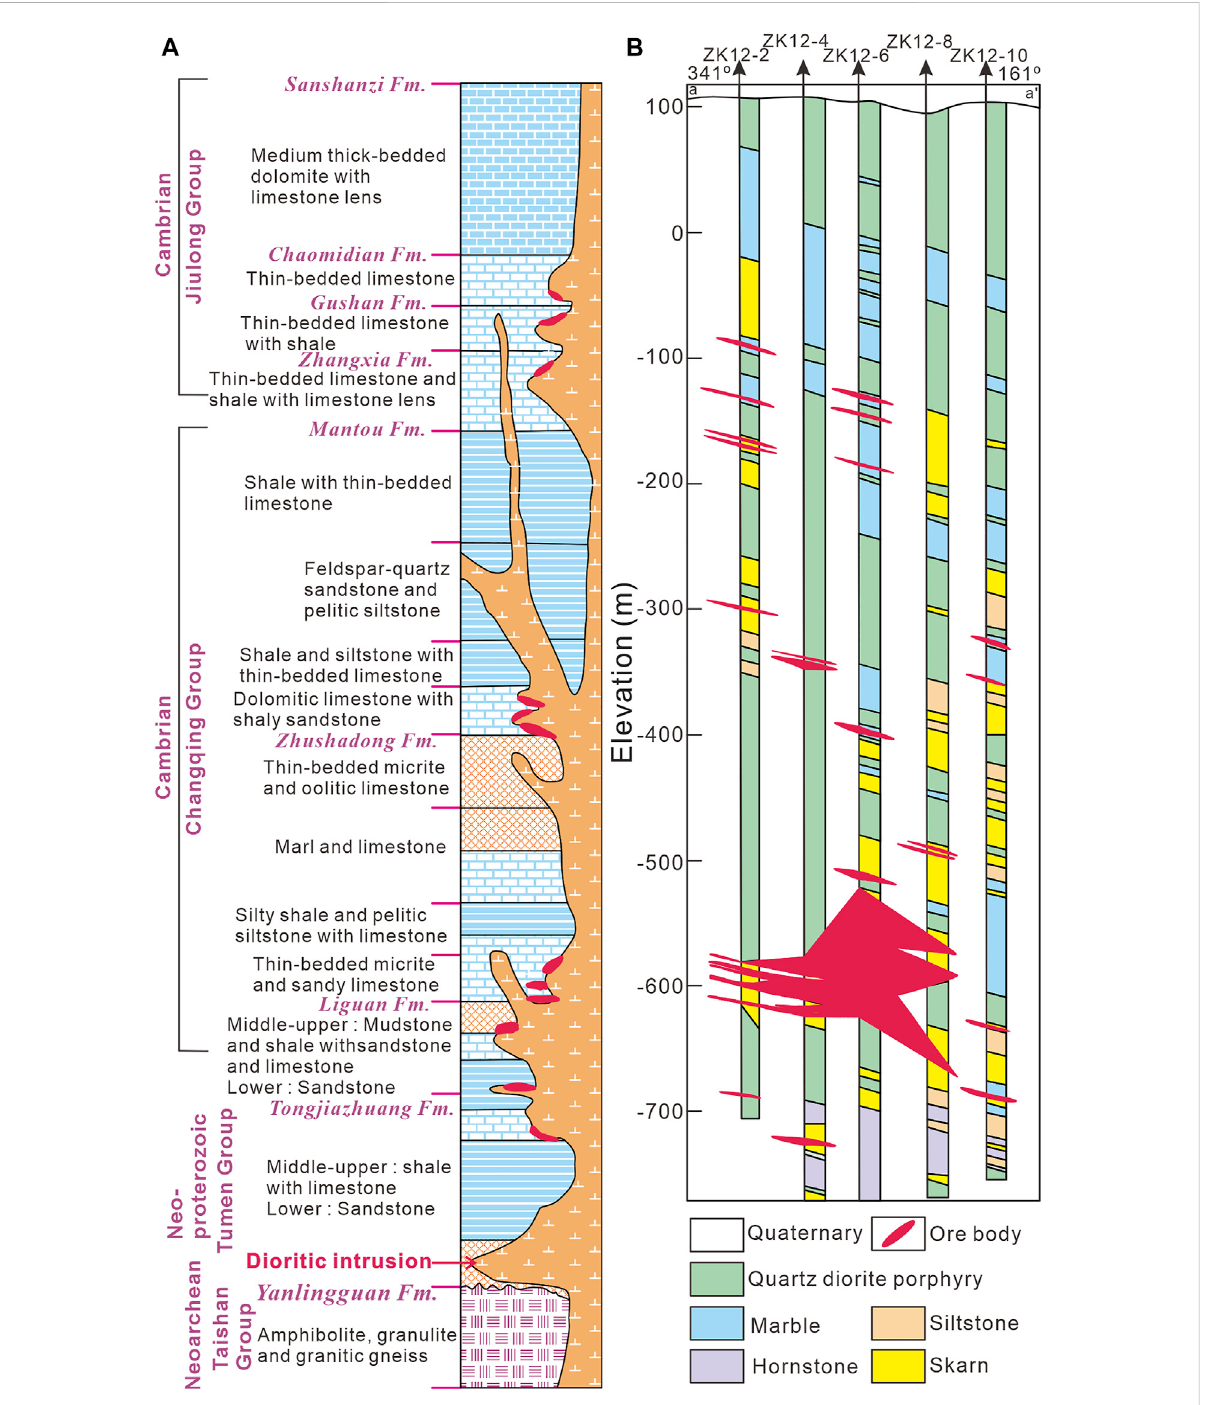
FIGURE 4 Sketchmapshowing thestratigraphyandtheoccurrenceoforebodiesintheYi ’ nanAu – Cuskarn deposit (A) ,modi fi edafterDong etal.(2008); Geological cross-section along exploration line 12 of Jinlong ore segment (B) , modi fi ed after SDGM